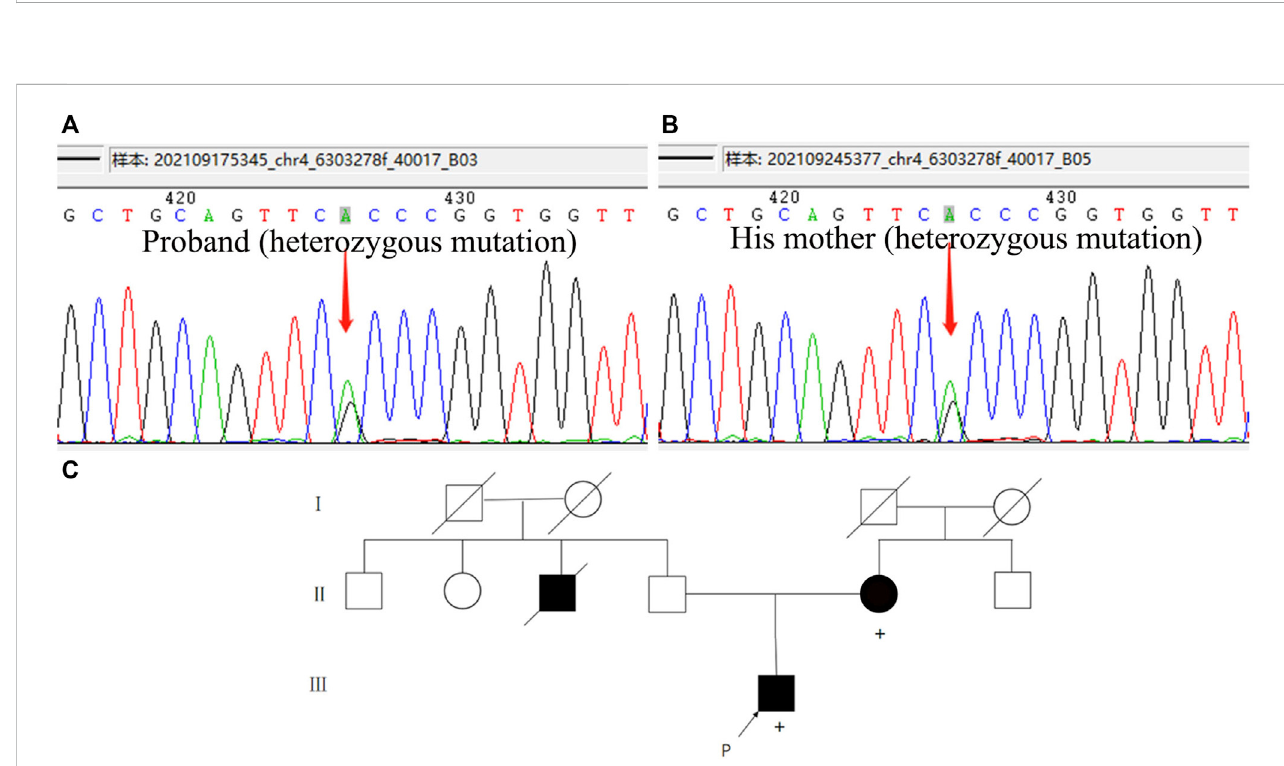
FIGURE 3 Whole exome sequencing results and family pedigree. (A,B) Both of the patient and his mother carried a heterozygous mutation in WFS1 c.1756G > A p.A586T. (C) Genealogicaltreeofthepatient.[Square,man;circle,woman;black- fi lledsymbol,affectedindividual(withcognitiveimpairment);emptysymbol, unaffected individual; P (arrow), proband; diagonal black line, deceased; +, individual with WFS1 gene mutation; consanguineous marriage was not observed in this family].